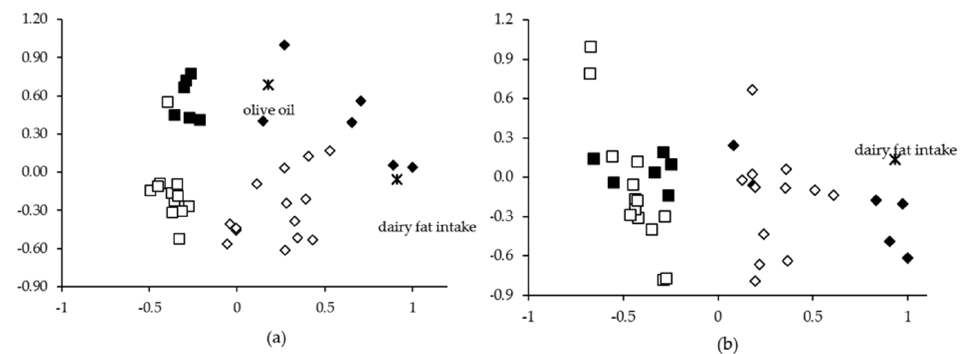
Figure 1. Two-dimensional plots representing the normalized scores for PC1 (x axis) and PC2 (y axis) obtained for plasma ( a ) and erythrocyte ( b ) samples of the intervention study ( n = 10): samples after a diet without dairy products ( (cid:3) , (cid:4) ); samples after a diet rich in dairy products ( ♦ , (cid:7) ). Open symbols: olive oil consumption below 25 g/day; full symbols: olive oil consumption above 25 g/day. The principal component analyses (PCA) were carried out including plasma or erythrocyte concentrations of all individual FAs and the intake of dairy fat, olive oil, red meat, fish, and cakes and biscuits. PC1 explained 32.85% and 35.57% of the total variance in plasma and erythrocytes samples, respectively, and PC2 explained 13.25% and 12.18%, respectively.